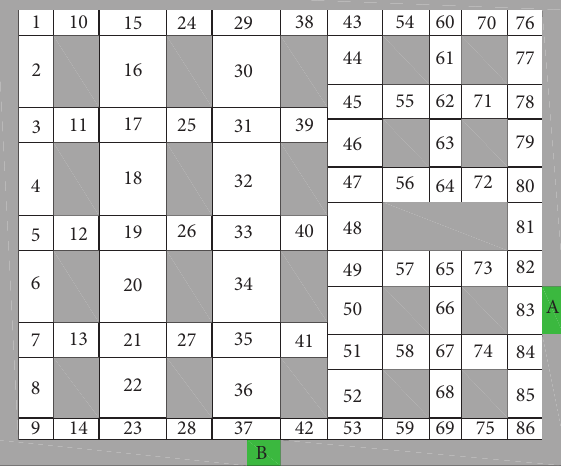
Figure 5: The layout and grid division of the simulation